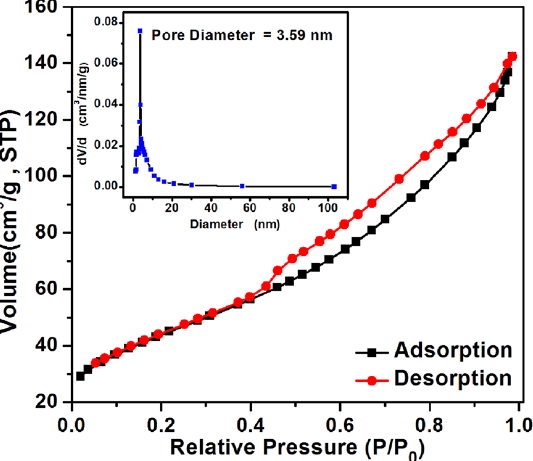
Figure 3. N 2 adsorption-desorption isotherms of as-synthesized PTO-4 nanoparticles, and the inset is the corresponding pore size